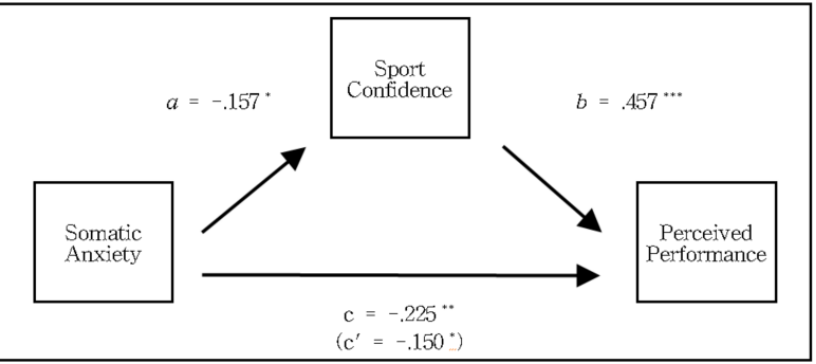
Figure 1. Mediating effect of sports confidence on the relationship between somatic anxiety and